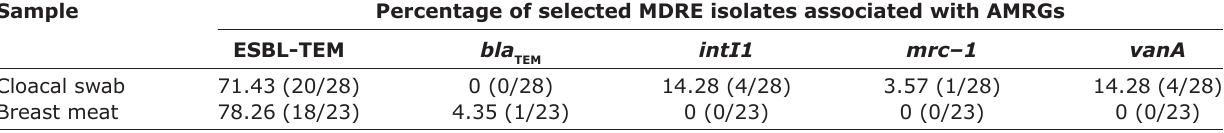
Table-4: Detection of the five AMRGs 1 of selected phenotypic MDRE 2 isolates from slaughterhouses in Nakhon Ratchasima Province, Thailand.